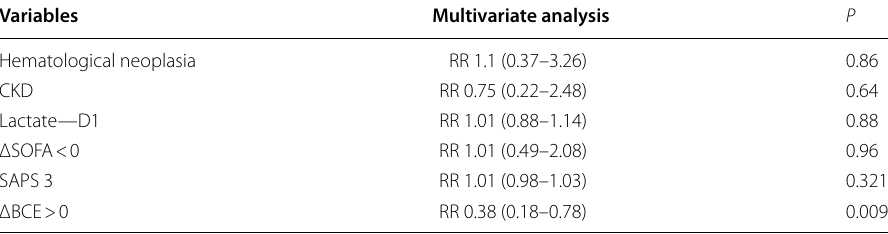
Δ mathematically indicates the pairwise variation between values obtained at day 3 (D3) minus day 1 (D1), for the indicated variable. SOFA sequential organ failure assessment, SAPS 3 simplified acute physiology score 3, BCE biochemical coupling efficiency, CKD chronic kidney disease, RR risk